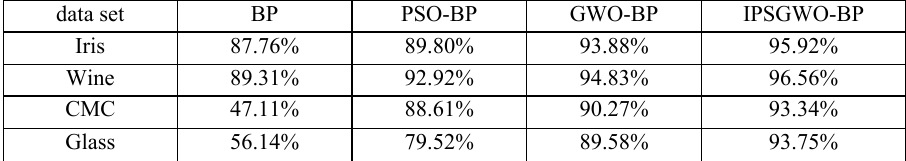
Table 3. Classification results of each algorithm on four data sets.